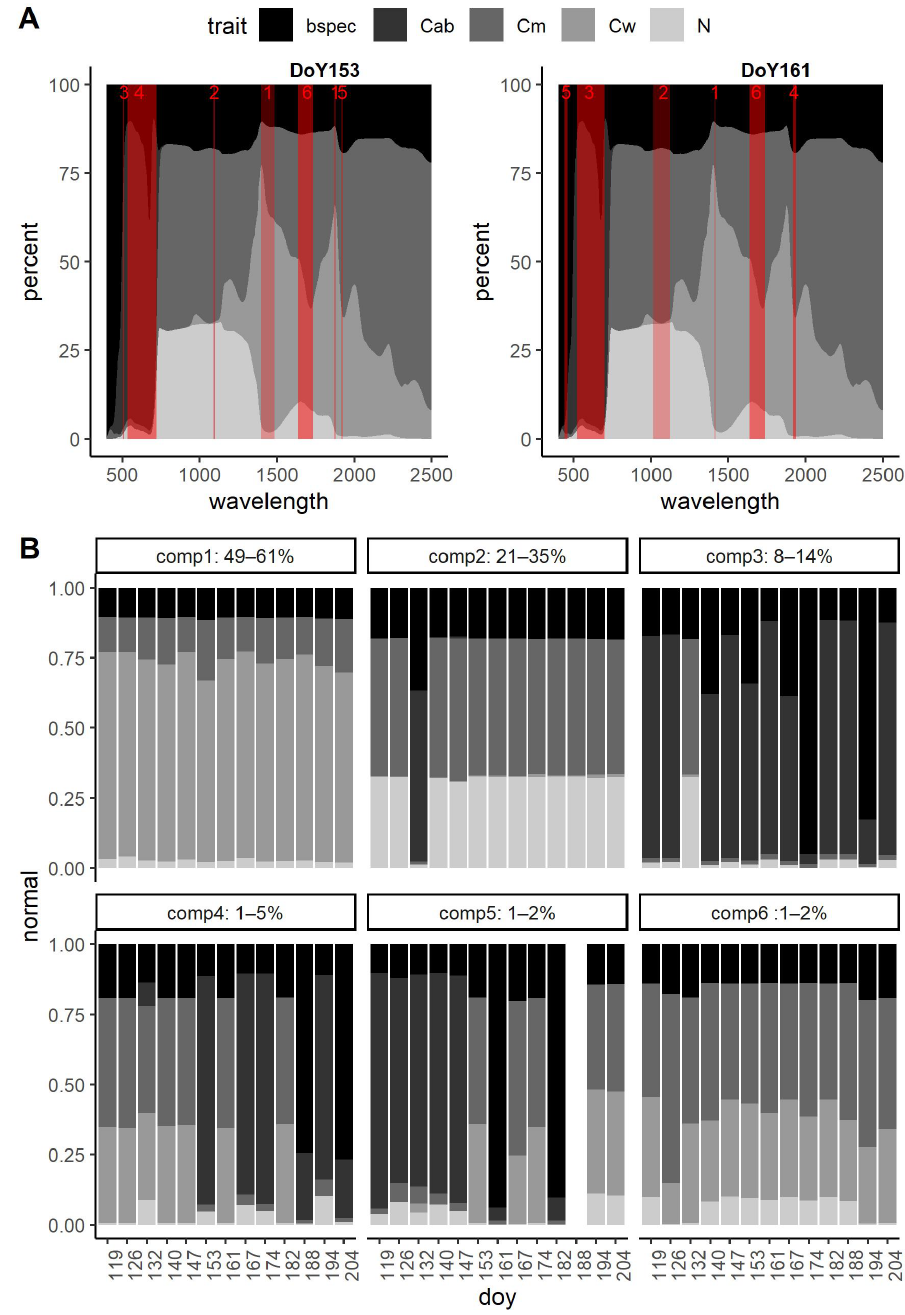
Figure 9. ( A ) The global sensitivity analysis of the radiative transfer model PRO-COSINE for leaf clip data with overlaid waveband selection for the first six components for two example time points (DoY 153 and 161); ( B ) the probability of the importance of traits for each of the six components over time using the wavelength selection from the best performing sPLS-DA models for each sampling date. The range of variance between model runs for each model component is presented in the panel